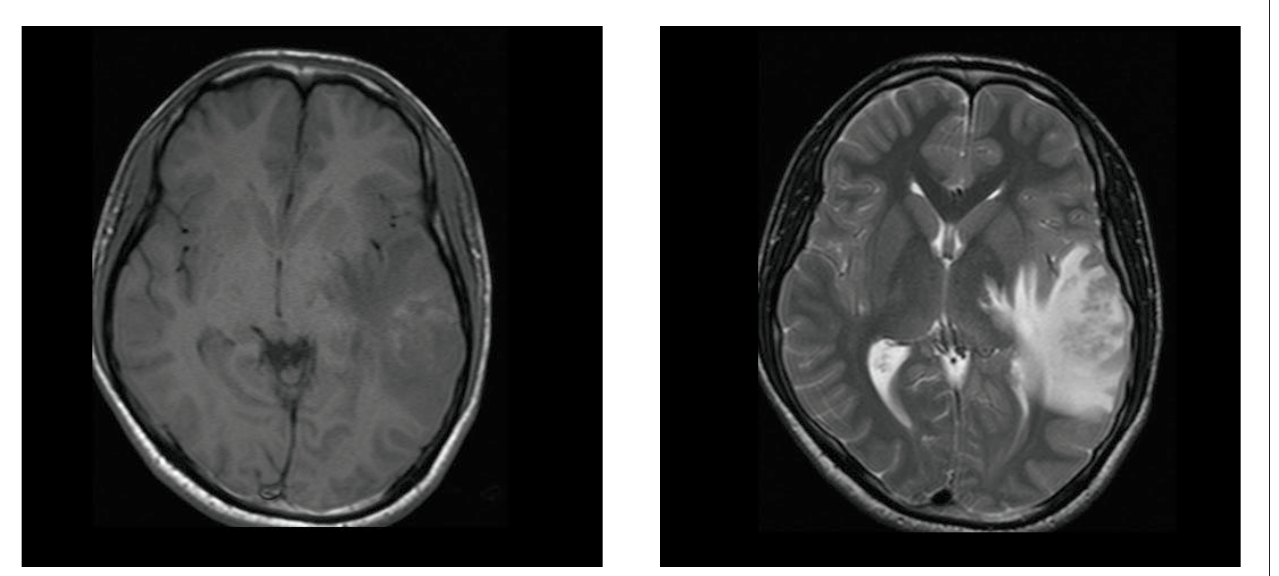
infiltrate.Fig. Fig. 2. Axial MR T2WI demonstrating a hyperintense mass-like lesion with